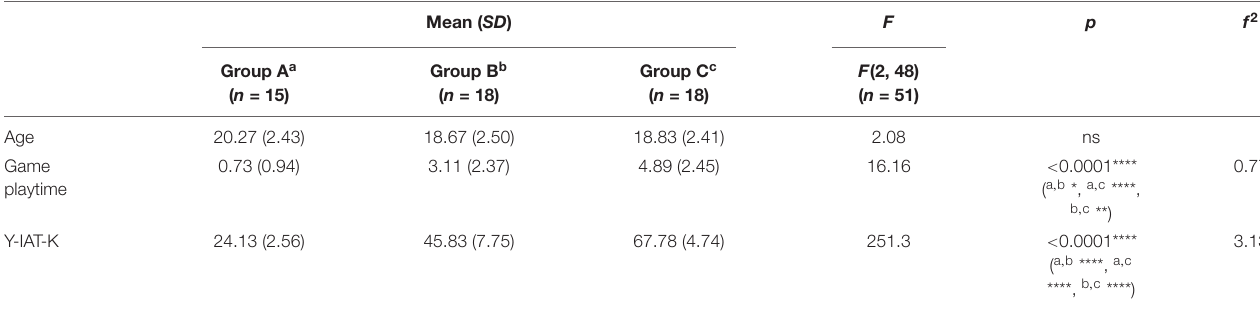
TABLE 1 | Mean, standard deviation ( SD ), F , and p -value of analysis of variance (ANOVA) on demographic data.